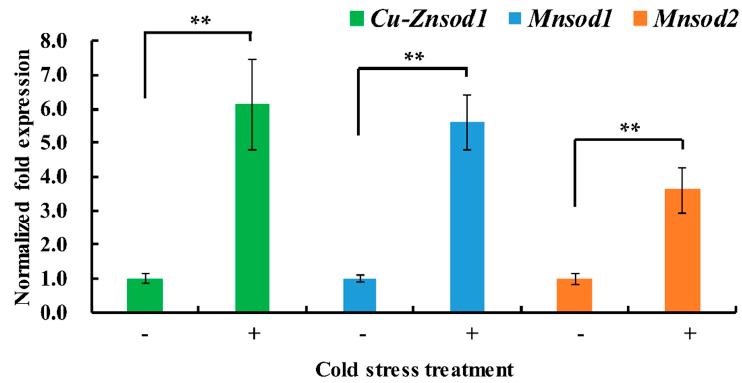
Figure 4. Differential expression of sod genes in V. volvacea H1521 stressed at low temperature for different times. Control ( − ), hyphae were incubated in phosphate buffered solution (PBS) buffer (0.02 mol/L, pH 8, 34 °C) for 1.5 h at 34 °C. Cold stress treated (+), hyphae were incubated in PBS buffer (0.02 mol/L, pH 8, 34 °C) for 0.5 h at 34 °C and then in PBS buffer (0.02 mol/L, pH 8, 4 °C) at 4 ˝ C for 1 h. Data are the averages of four independent experiments. The error bars show the standard error of the mean. Statistical analysis was performed using least significant difference (LSD) test, ** p <